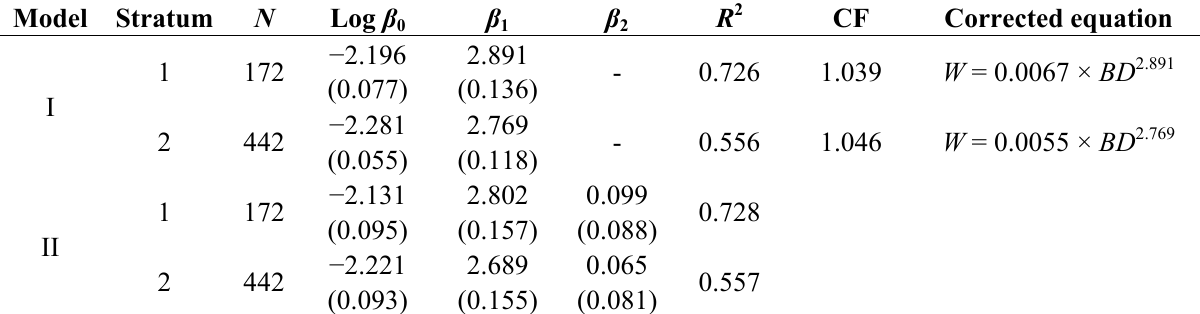
Table 4. Estimated values of the regression parameters with their statistical measures of